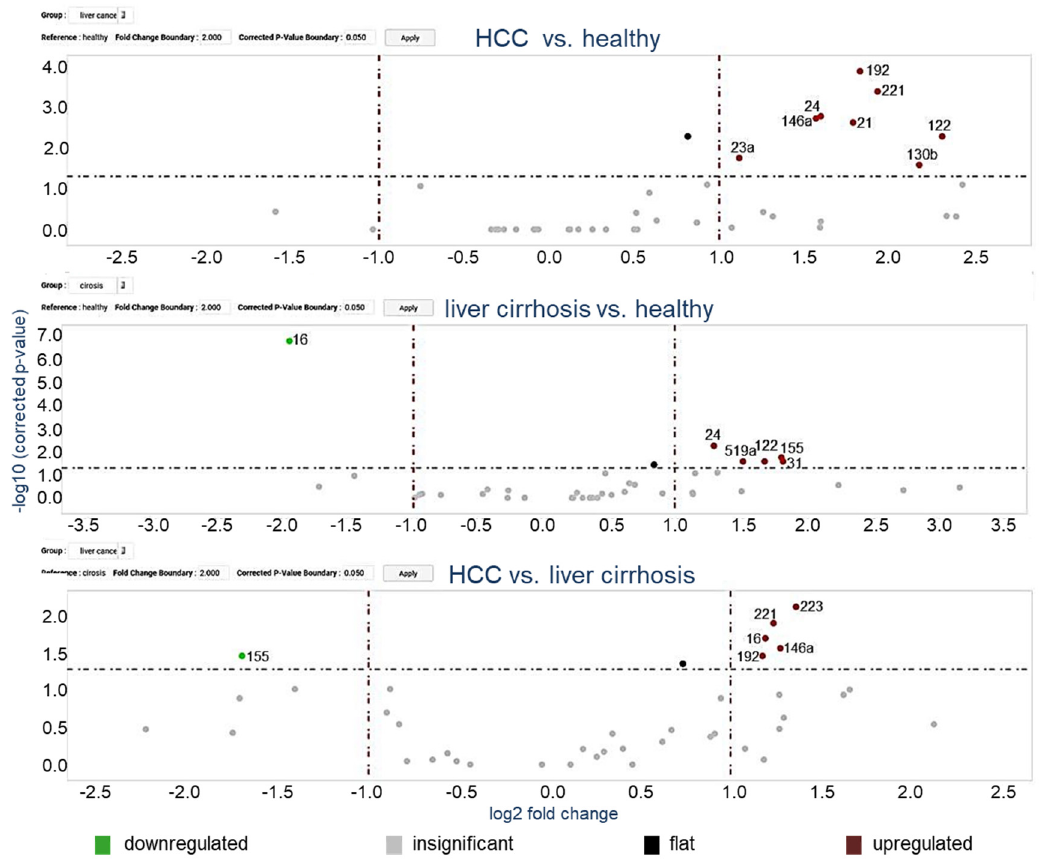
Figure 2. Volcano plot of 45 exosomal miRNAs. The volcano plots of p -values vs. fold changes compare the levels of exosomal miRNAs in 24 HCC patients and 37 liver cirrhosis patients with 20 healthy individuals, as well as 24 HCC patients with 37 liver cirrhosis patients. The grey dashed line refers to the threshold value corresponding to a corrected p -value of p = 0.05. Significantly downregulated exosomal miRNAs are shown as green dots, significantly upregulated exosomal miRNAs as red dots. Grey dots represent non-significant changes. p -values are calculated by the student t -test and corrected according to the Benjamini and Hochberg method.